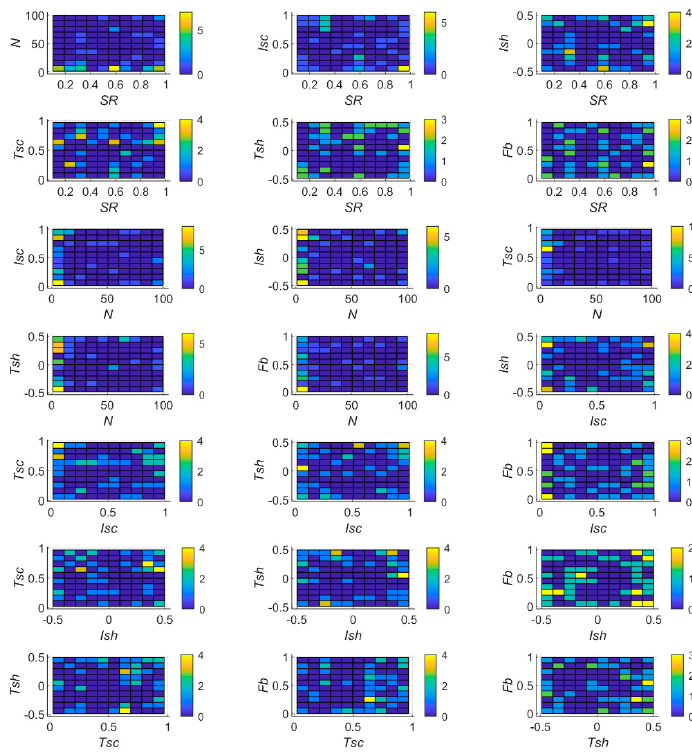
Figure 9. Best hyperparameters frequency for the Brazilian dataset errors using EI-BO optimized ESN.